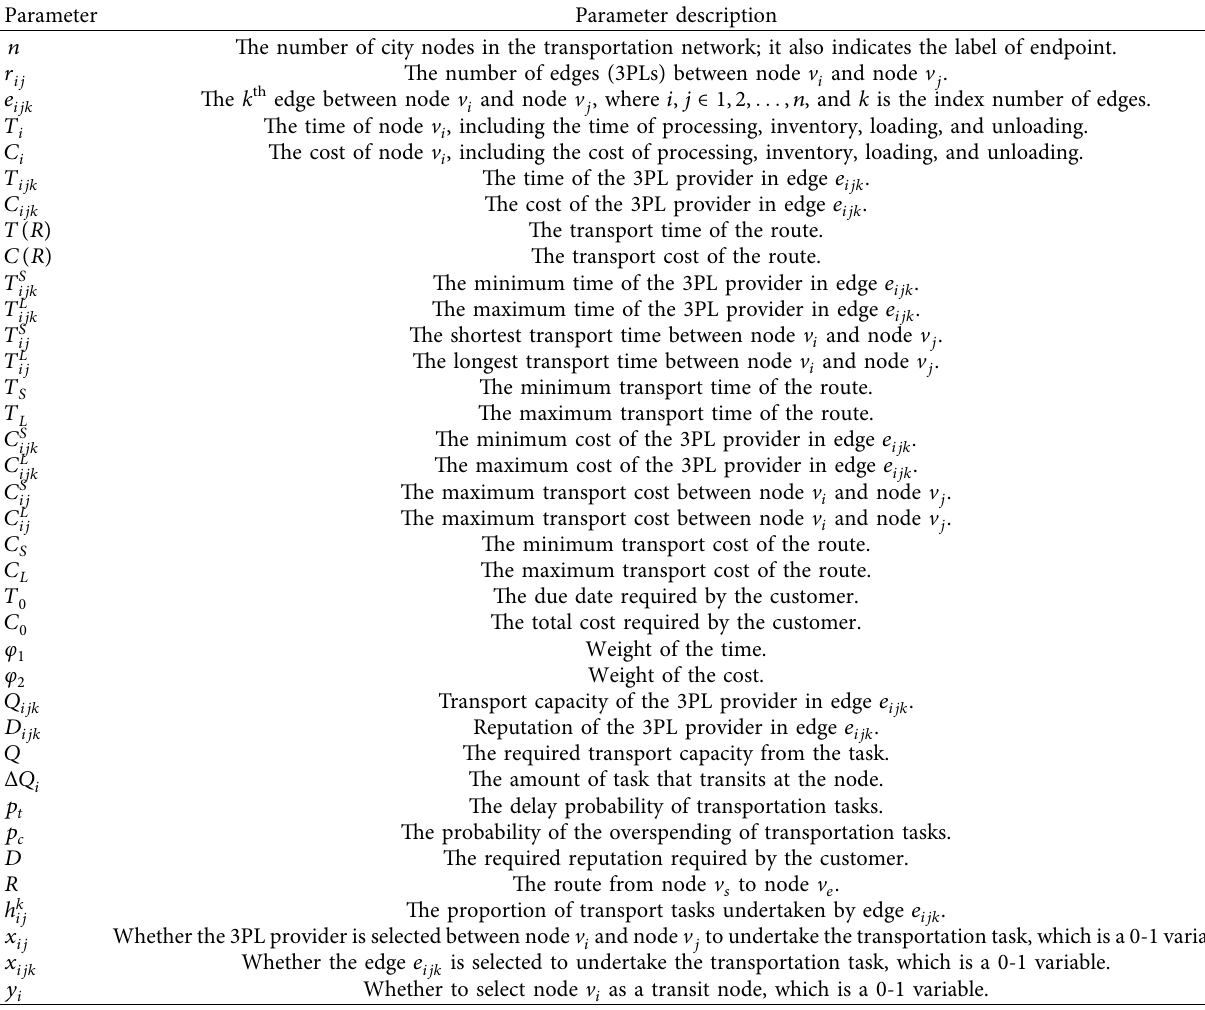
Table 1: Parameter definition of the model. Parameter Parameter description